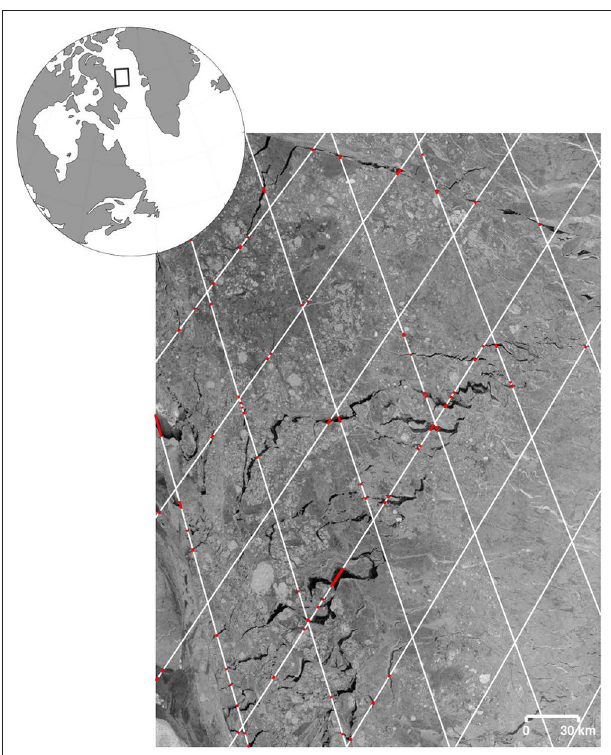
FIGURE 4 | Sentinel 1 SAR (Synthetic Aperture Radar) image on 10th April 2017 in the Baffin Bay (pixel size: 100 100m), showing open-water fractures × (black pixels) in the ice pack. White lines depict CALIOP tracks over a 16-day orbit repeat cycle. Red dots indicate where the lidar shots ( 100m footprint; ∼ 330m pulse-to-pulse along-track distance) targeted open-water areas. These represent about 3% of the total shots shown on this